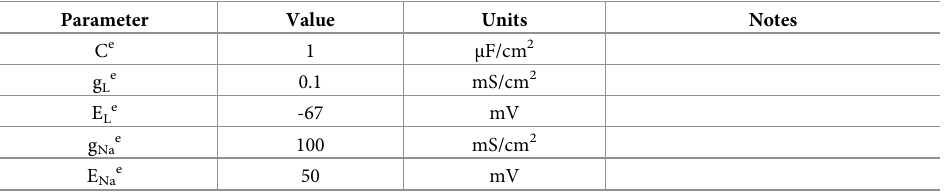
Table 3. Parameters used for modeling IPSP-induced network resonance (Figs 7–8). Parameter Value Units